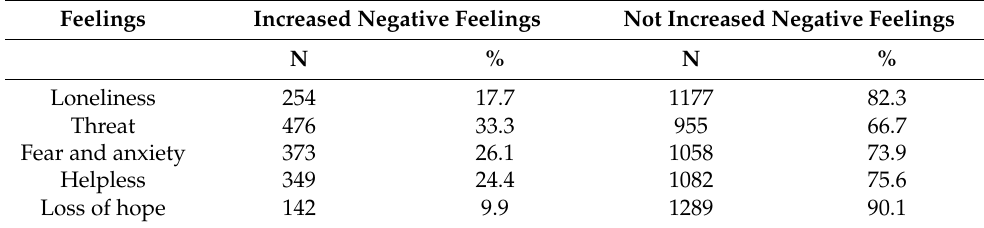
Table 3. Change in emotional state during the coronavirus pandemic.